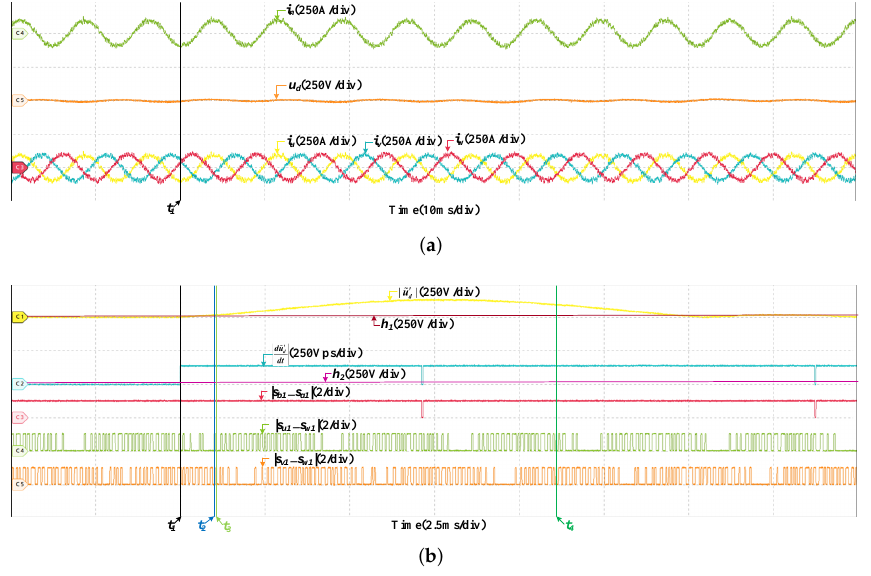
Figure 10. HIL results when the offset fault occurs in S Cn at 200 km/h. ( a ) The results of the grid current, DC-link voltage and stator currents. ( b ) The results of fault diagnosis.